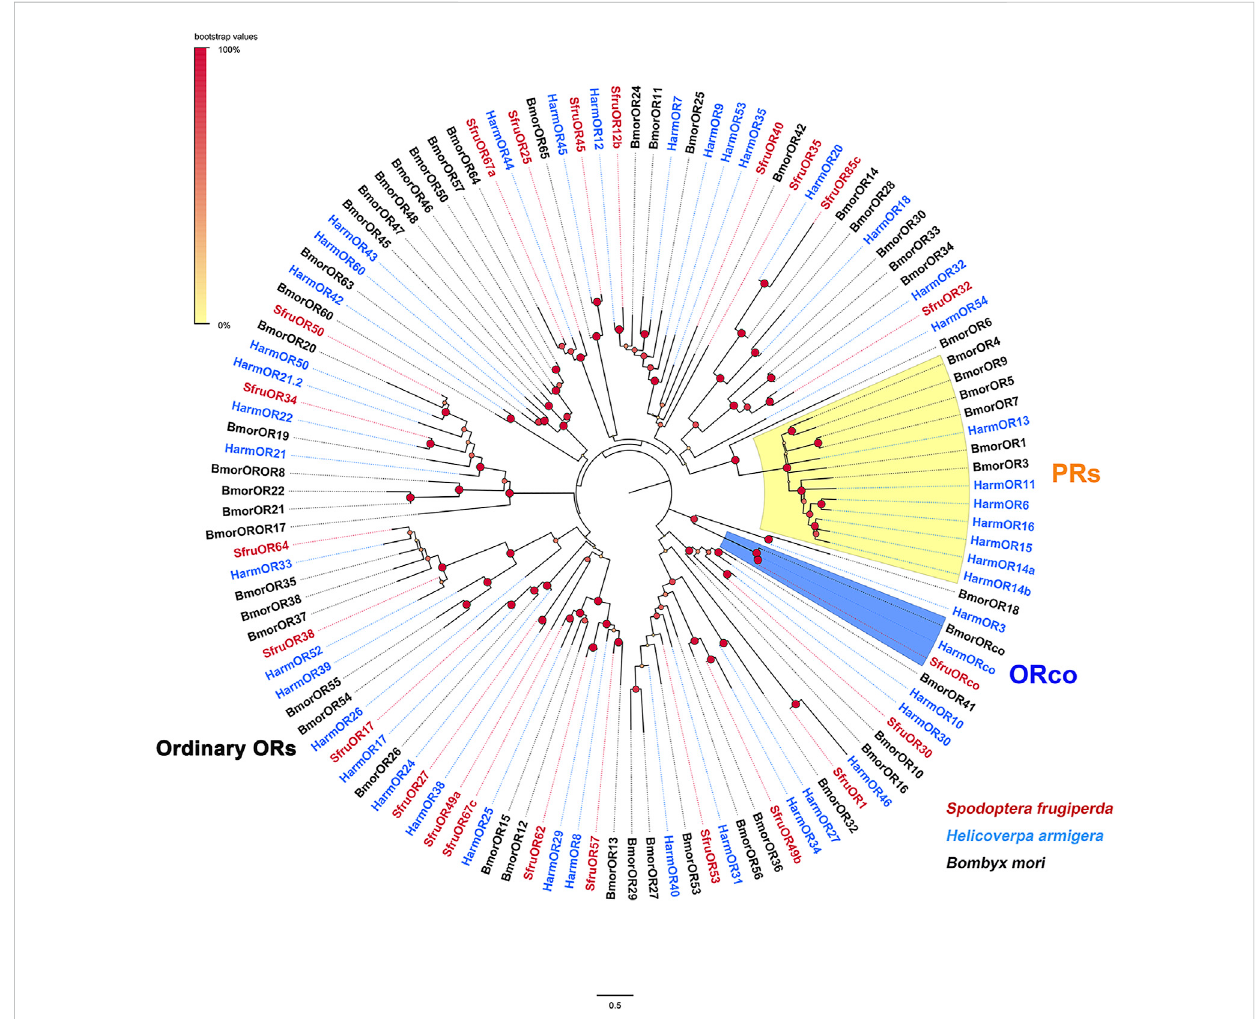
FIGURE 1 Phylogenetic analysis of the candidate SfruORs from the transcriptome of S . frugiperda tarsi and ORs from H . armigera and B . mori .